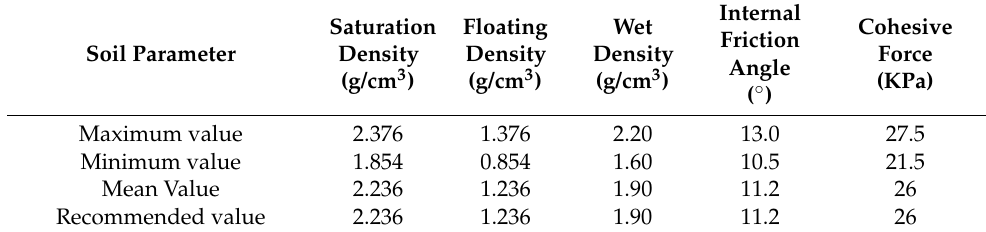
Table 2. Physical and mechanical parameters of the soil.